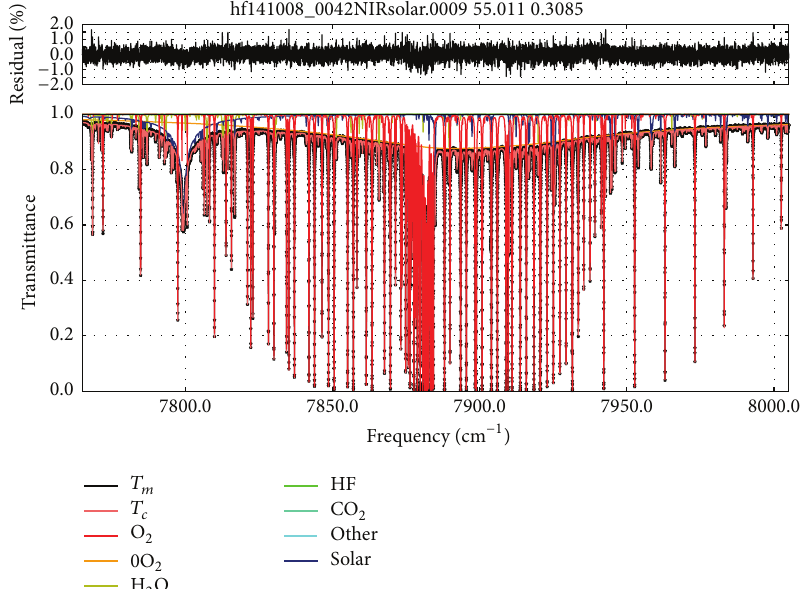
Figure 4: O 2 spectral fitting within 7885 cm −1 window: the spectrum was recorded on October 8, 2014, 0:47 (UTC). Black lines are the measurements, orange lines are the fitted transmittance, and contributions from individual gases are shown in color. Fitting residuals ( 𝑇 𝑚 −𝑇 𝑐 ) for O 2 are 0.3085%.